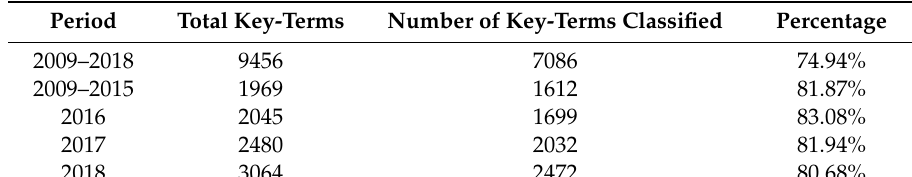
Table 6. The number and percentage of key-terms classified in the thematic analysis process for each period.